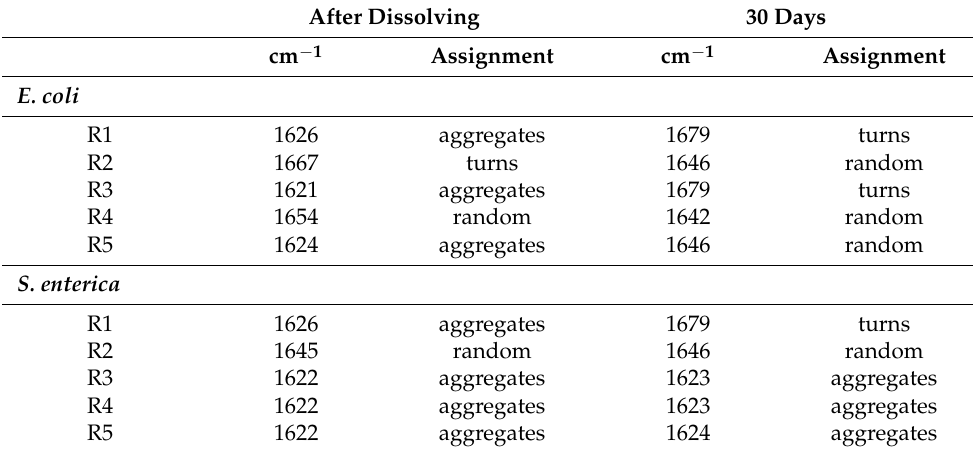
Table 1. Secondary structure assignments of the studied peptides with sequences from E. coli and S.